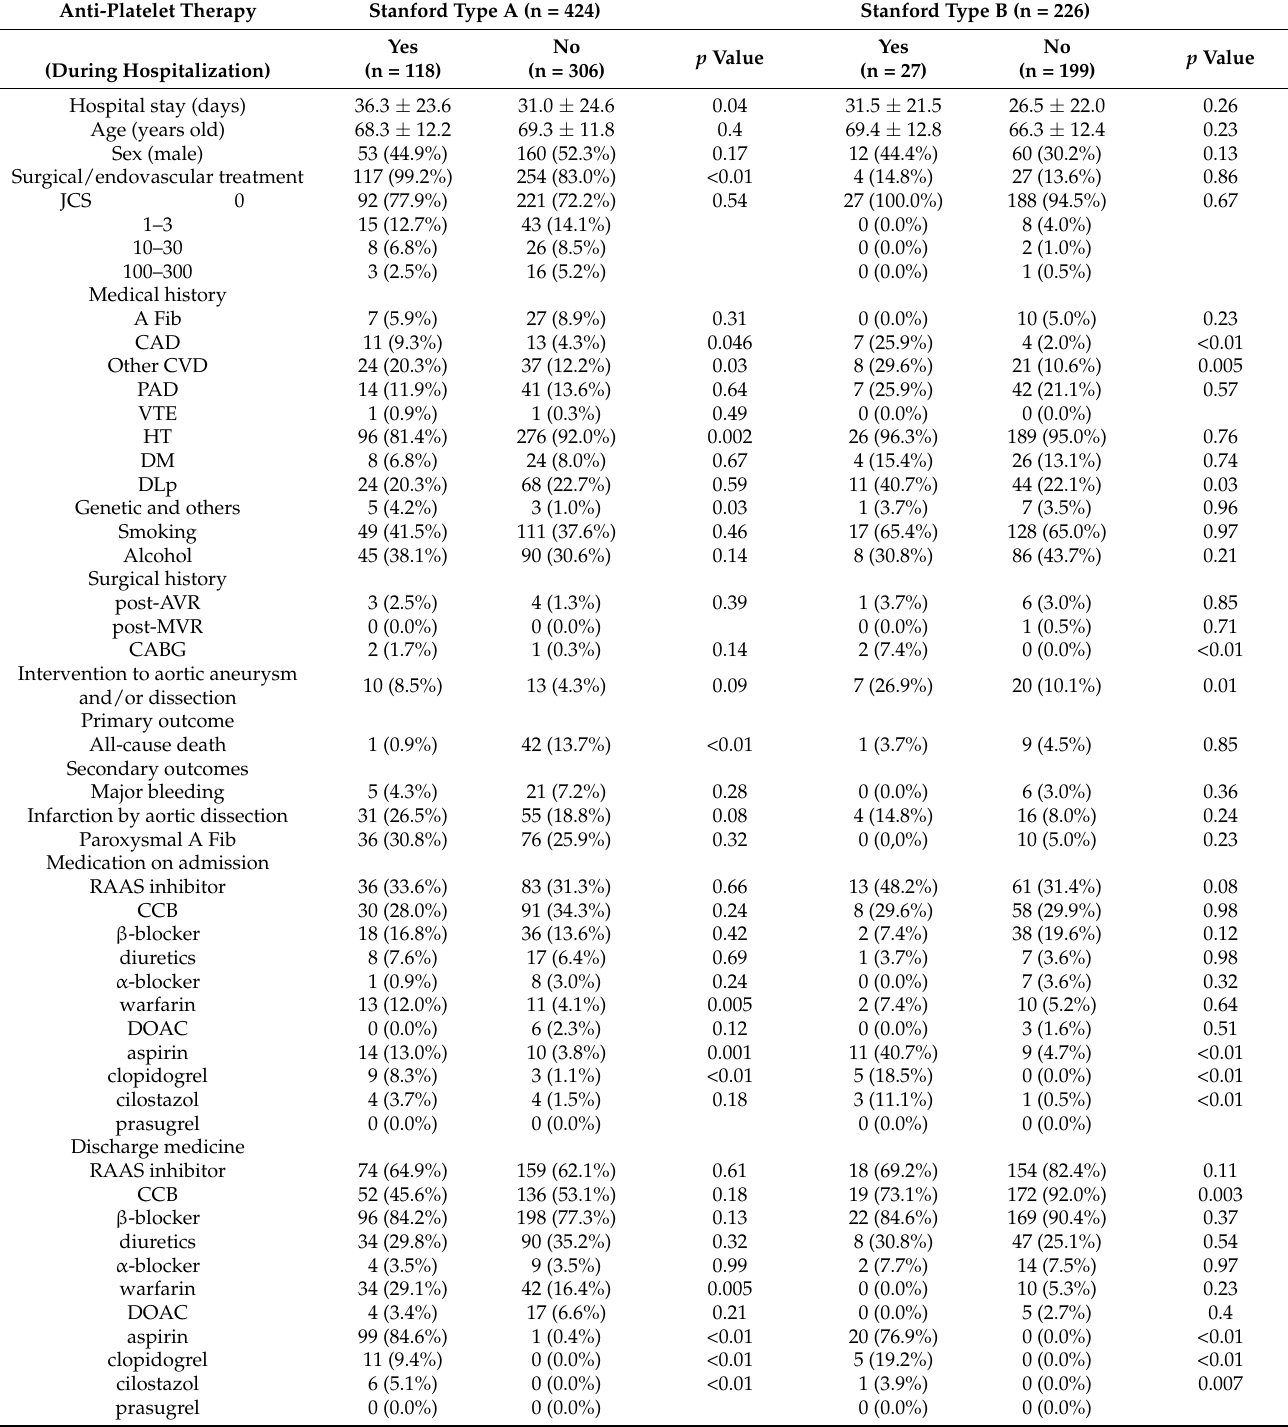
Table 8. Clinical characteristics of HOSPITALIZED acute aortic dissection with and without anti- platelet